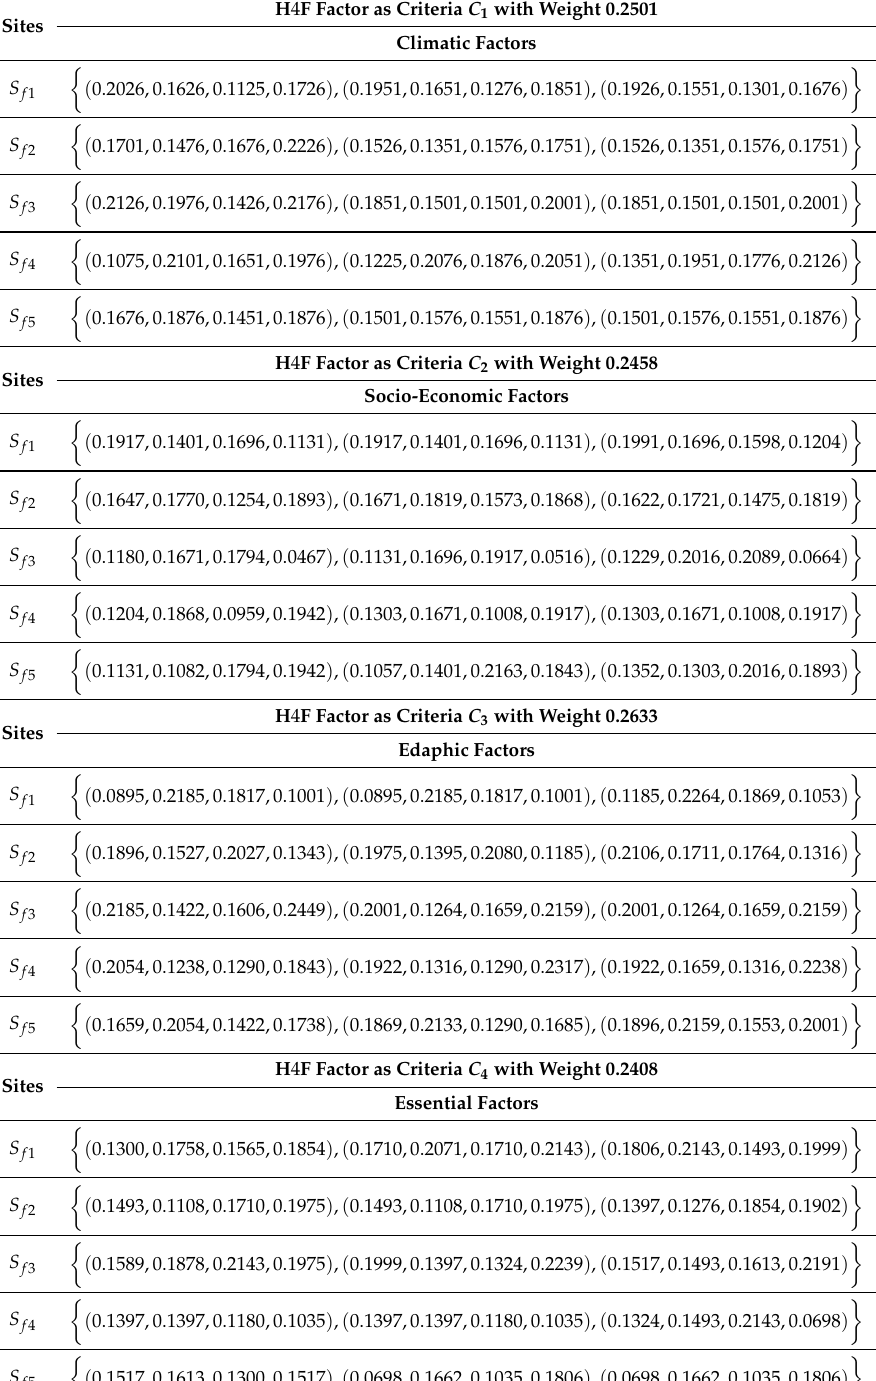
Table 11. Tabular representation of weighted pessimistic H4F decision matrix. H 4 F Factor as Criteria C 1 with Weight 0.2501 Sites Climatic Factors